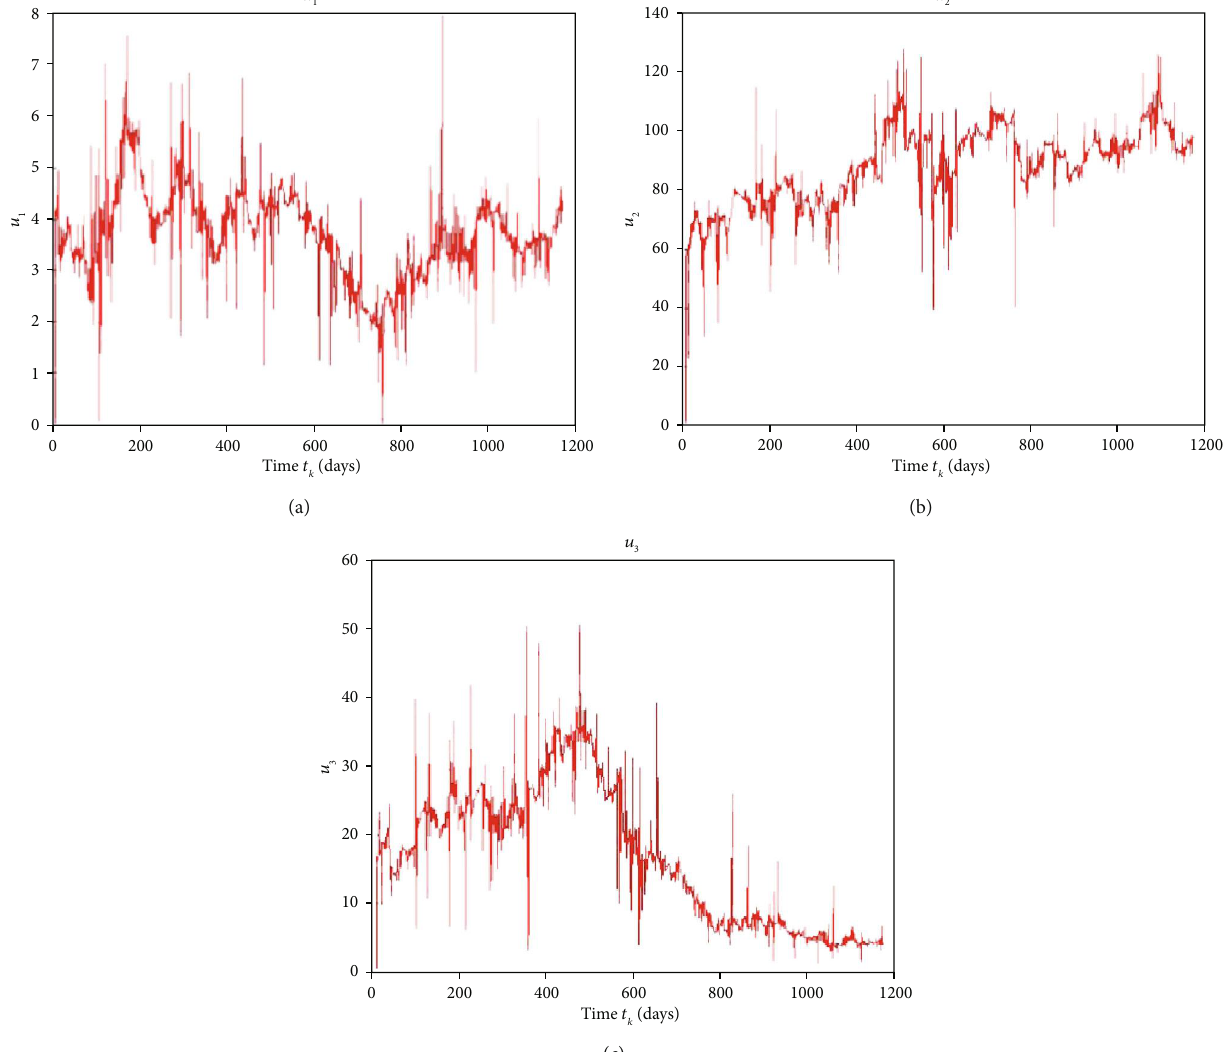
Figure 8: The graph of mean level u